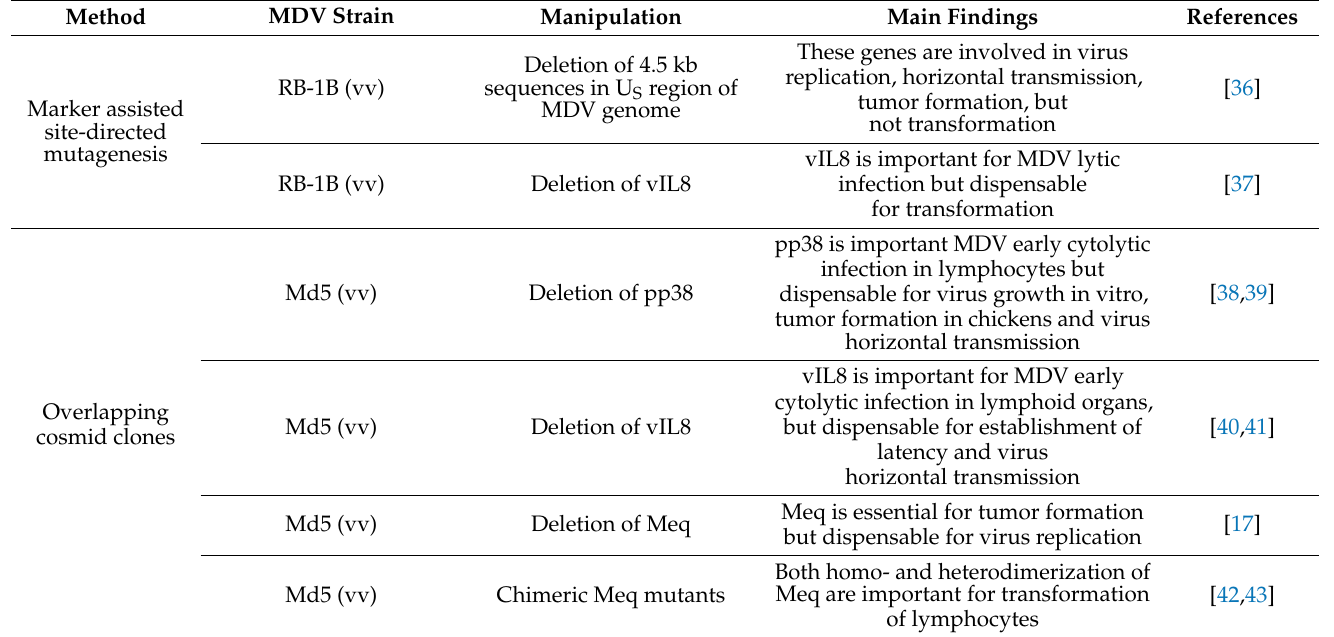
Figure 2. Schematic of marker assisted site-directed mutagenesis. Apart from TK, other markers, such as β -galactosidase (LacZ) and fluorescent proteins, were also used as selection or rescue markers in MDV studies (Table 2). Parcells et al. constructed a recombinant MDV mutant (named RB1B ∆ 4.5 lac ) by inserting the lacZ gene of E. coli into the unique short (U S ) region of MDV resulting in the deletion of a 4.5 kb DNA fragment. The RB1B ∆ 4.5 lac exhibited decreased in vitro growth, as well as impaired early cytolytic infection, horizontal transmission, tumor incidence and mortality in chickens, without affecting the latency or transformation of T lymphocytes [36] (Table 2). Using soluble-modified green fluorescent protein (smGFP) as selection marker, Parcells et al. generated a viral interleukin 8 ( vIL8 ) deletion mutant MDV and showed that vIL8 is important for MDV lytic infection but dispensable for transformation [37]. Table 2. Selected studies of MDV using different genome manipulation methods.